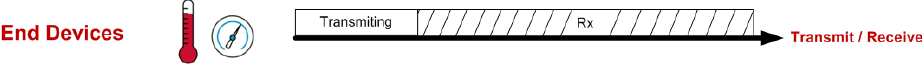
Figure 4. Class B transmission.